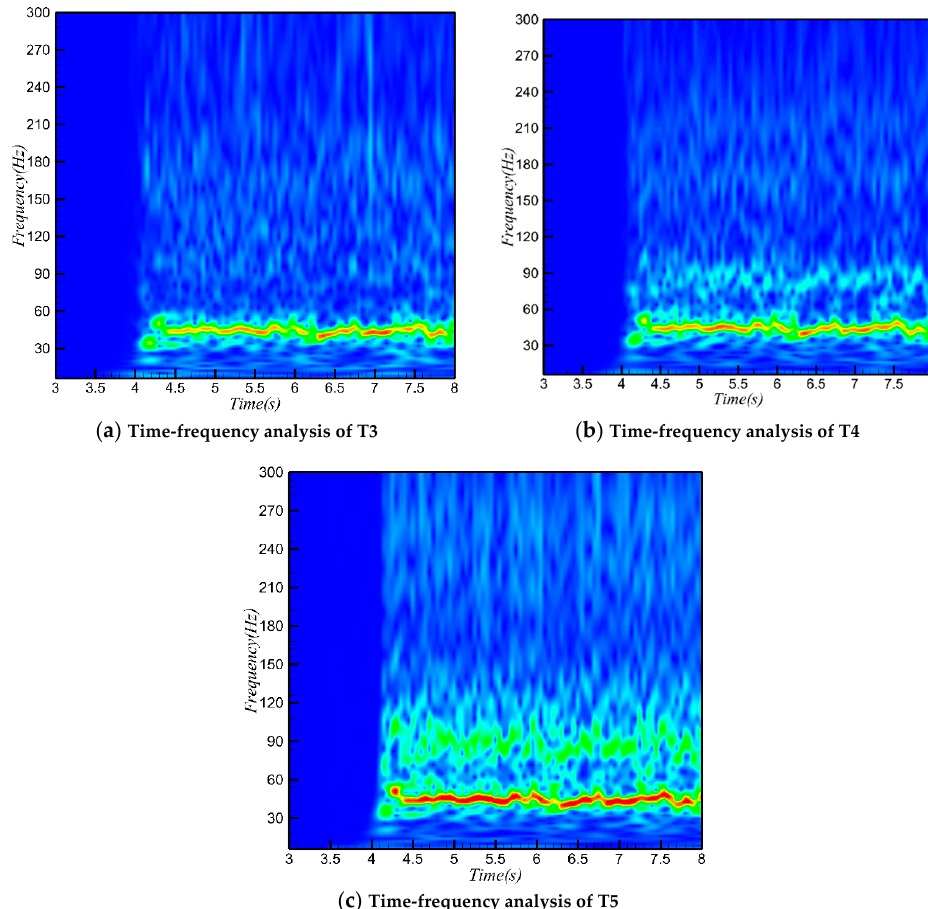
Figure 13. Time-frequency analysis of T3, T4, and T5.